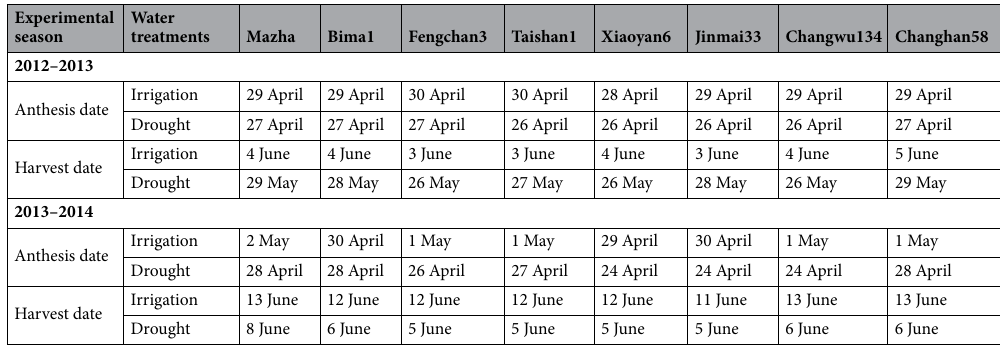
Table 2. Anthesis date and harvest date of all cultivars in the experimental